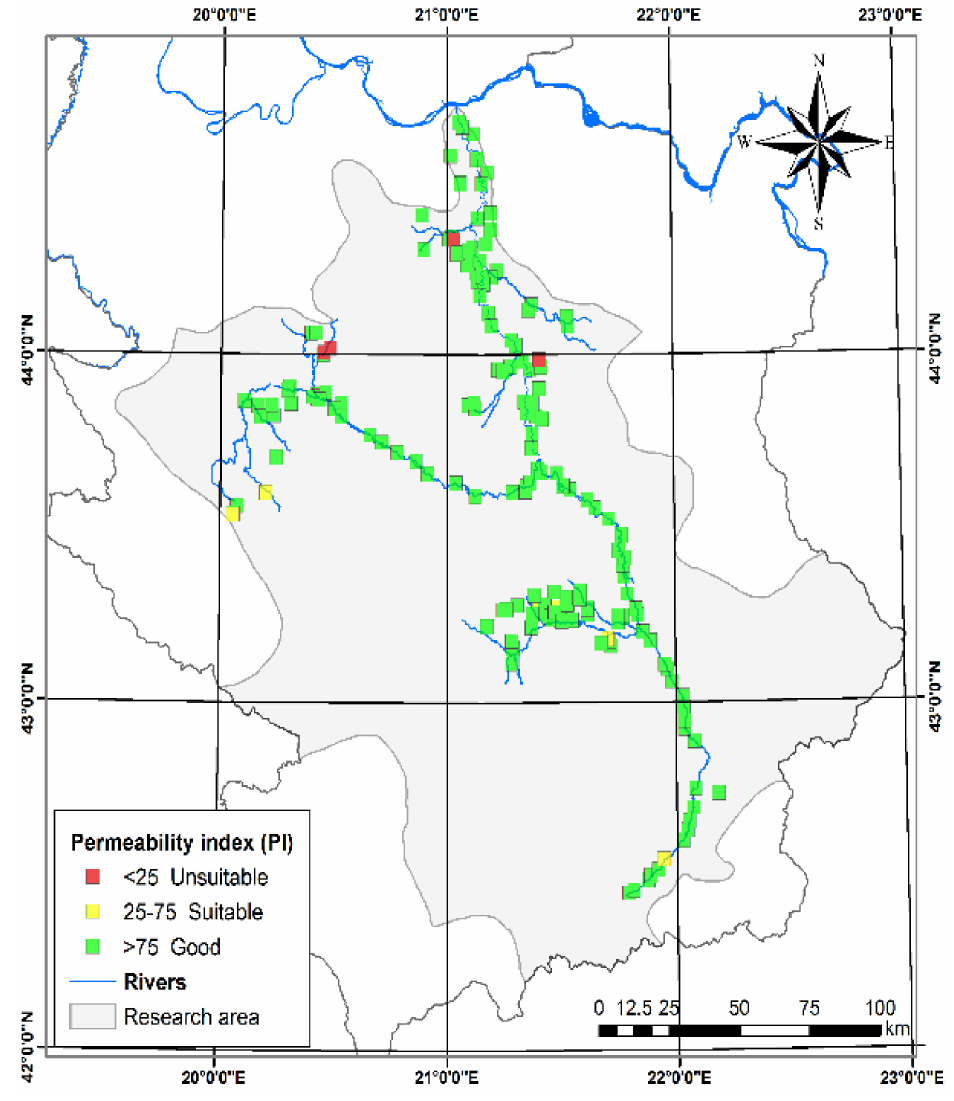
Figure 12. Spatial distribution of